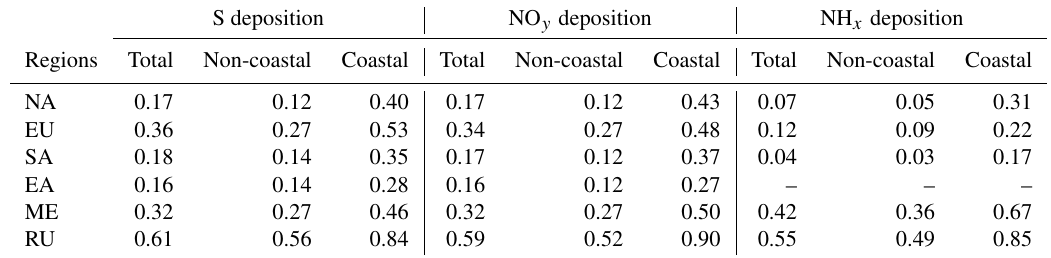
Table 2. Extra-regional emission reduction (RERER) values of S, NO y and NH x deposition for continent, non-coastal and coastal regions. The RERER values are calculated by dividing the (cid:49) Depo due to foreign emission reduction by (cid:49) Depo due to global (foreign + own region) emission control. The total column gives the RERER for coastal and non-coastal